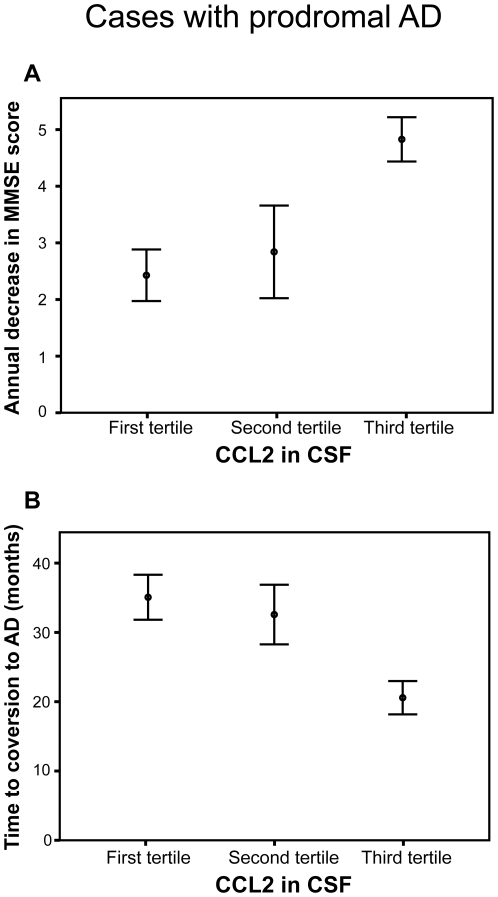
The disease progression rate is increased in cases with prodromal AD who have higher levels of CCL2 in the cerebrospinal fluid at baseline.Panel A shows that prodromal AD cases in the highest tertile of CSF CCL2 at baseline exhibited a significantly higher annual decrease in MMSE score during the follow-up period compared to those in the lowest tertile (p<0.001, Mann Whitney U test). Panel B depicts that prodromal AD cases in the highest tertile of baseline CSF CCL2 exhibited a shorter time period to conversion to dementia compared to those in the lowest tertile (p<0.003, Mann Whitney U test). The CCL2 tertiles were established in the whole MCI cohort (first tertile = 292–584 pg/ml; second terile = 585–756 pg/ml; third tertile = 757–1369 pg/ml). Error bars indicate the standard error of the mean.